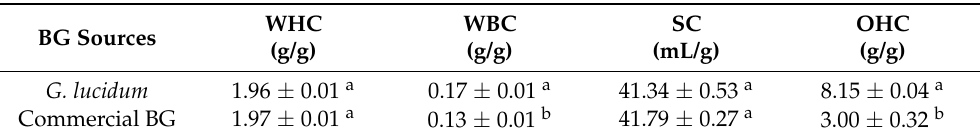
Table 6. Water-holding capacity (WHC), water-binding capacity (WBC), swelling capacity (SC), and oil-holding capacity (OHC) of antler-type G. lucidum BG and commercial